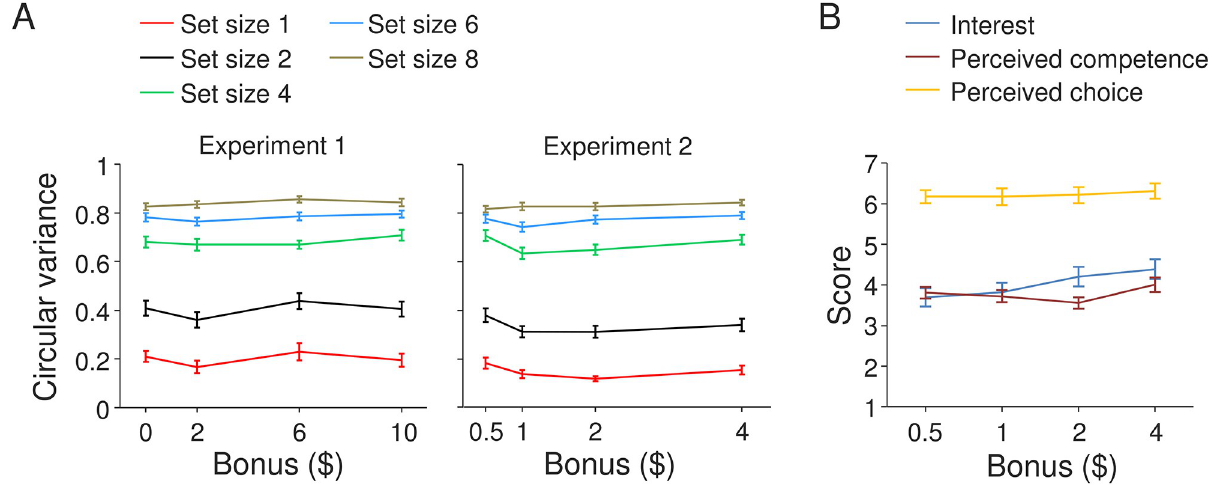
Fig 2. Effect of monetary reward level on memory precision and self-reported motivation scores in Experiments 1 and 2. (A) Subject-averaged circular variance of the estimation error distribution as a function of the amount of potential bonus in Experiments 1 (left) and 2 (right). (B) Intrinsic Motivation Inventory scores as a function of the amount of potential bonus, split by item category. Error bars indicate 1 s.e.m.